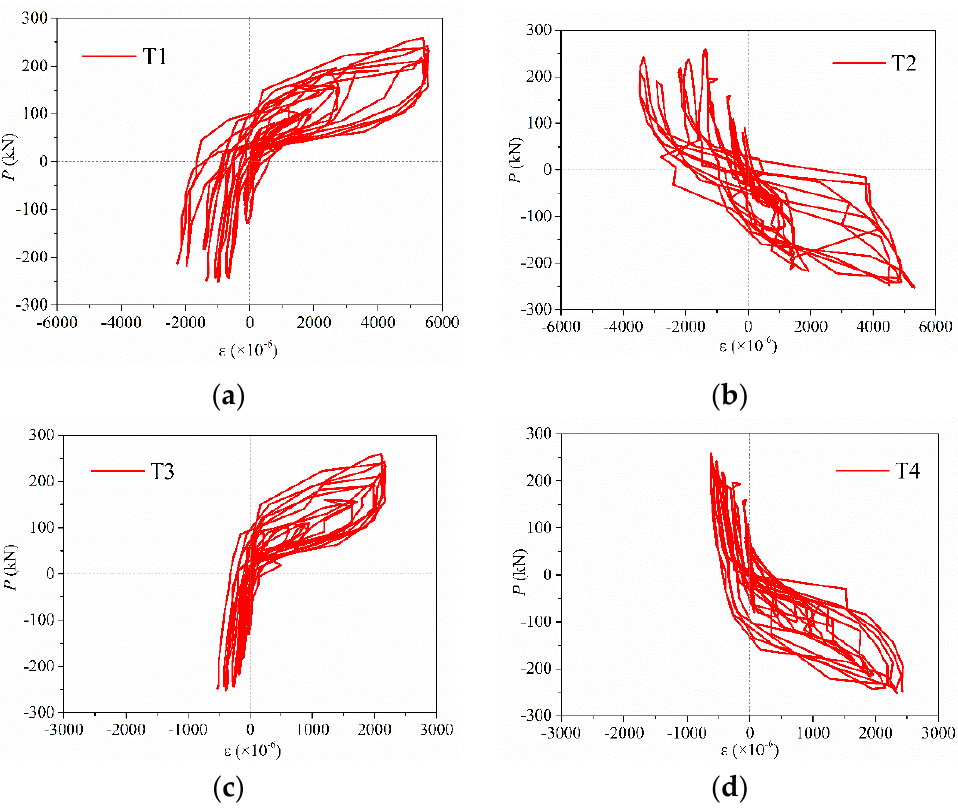
Figure 14. Force-strain hysteretic curves of T1-T4 for PW3: ( a ) T1 measure point; ( b ) T2 measure point; ( c ) T3 measure point; and ( d ) T4 measure point.